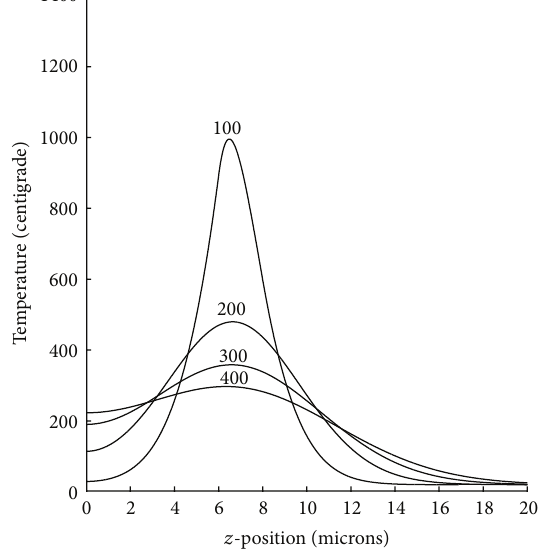
Figure 5: Temperature profiles on 𝑟 = 0 at times 𝑡 = 100 , 200, 300, and 400 𝜇 s for an uniformly distributed absorber in the dye layer (cooling phase). The laser is